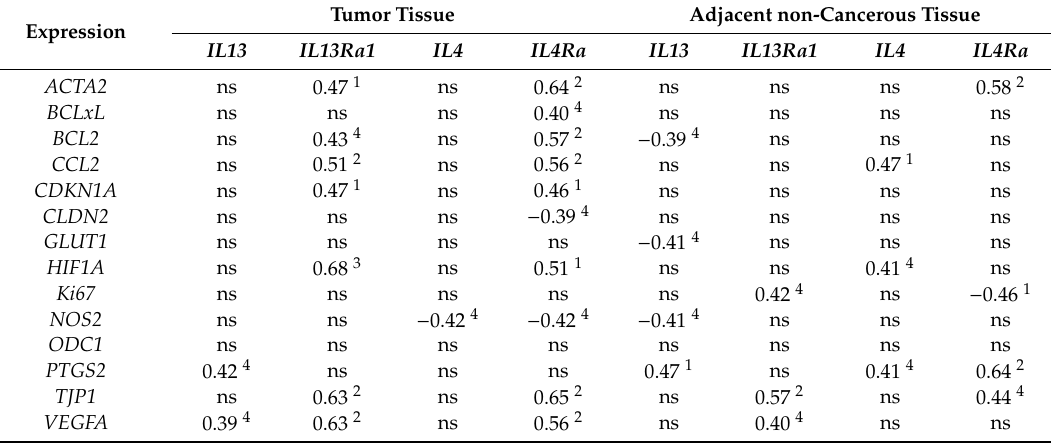
Table 10. Correlation pattern between expression of IL4 , IL4Ra , IL13 , and IL13Ra1 and expression of representative mediators relevant for cancer growth in tumor and tumor-adjacent non-cancerous tissue from CRC patients.